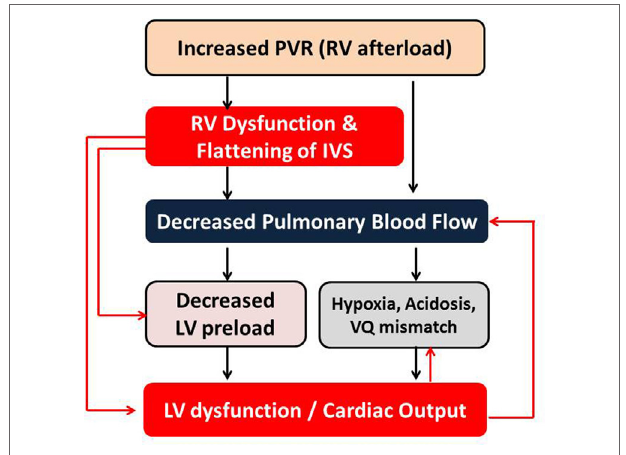
FiGURe 5 | Interdependency of right and left ventricular functions in the setting of pulmonary hypertension with increased PVR. LV, left ventricle; RV, right ventricle; PVR, pulmonary vascular resistance; IVS, interventricular septum; VQ,